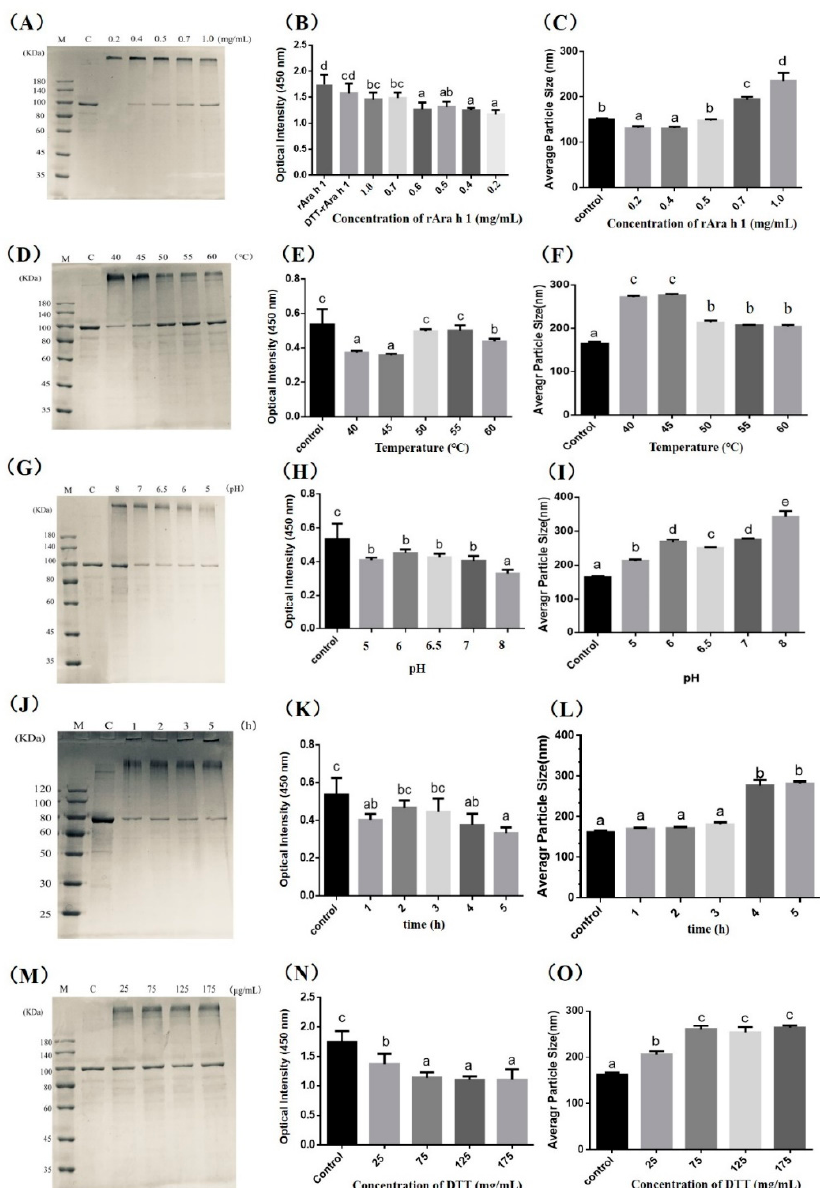
Figure 1. Influence of different reaction parameters on the molecular weight, IgE-binding capacity and particle size of cross-linked rAra h 1. ( A , D , G , J , M ) represents the effect of substrate concentration, temperature, pH, reaction time and DL-dithiothreitol (DTT) concentration on the molecular weight of rAra h 1 separately. ( B , E , H , K , N ) represents the effect of substrate concentration, temperature, pH, reaction time and DTT concentration on the IgE-binding efficiency of rAra h 1 separately. ( C , F , I , L , O ) represents the effect of substrate concentration, temperature, pH, reaction time and DTT concentration on the average particle size of rAra h 1 separately. The letters a, b, and c represent for the significant difference between results. M represent for the protein marker, and C represent for the control group.